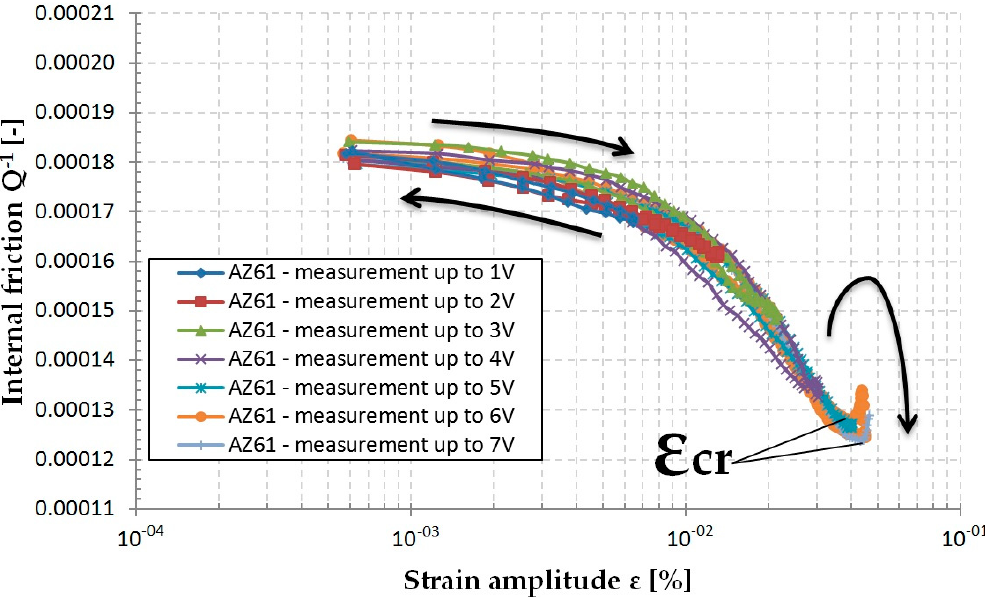
Figure 10. Amplitude dependencies of IF measured for the AZ61 alloy and increasing maximum strain amplitudes.